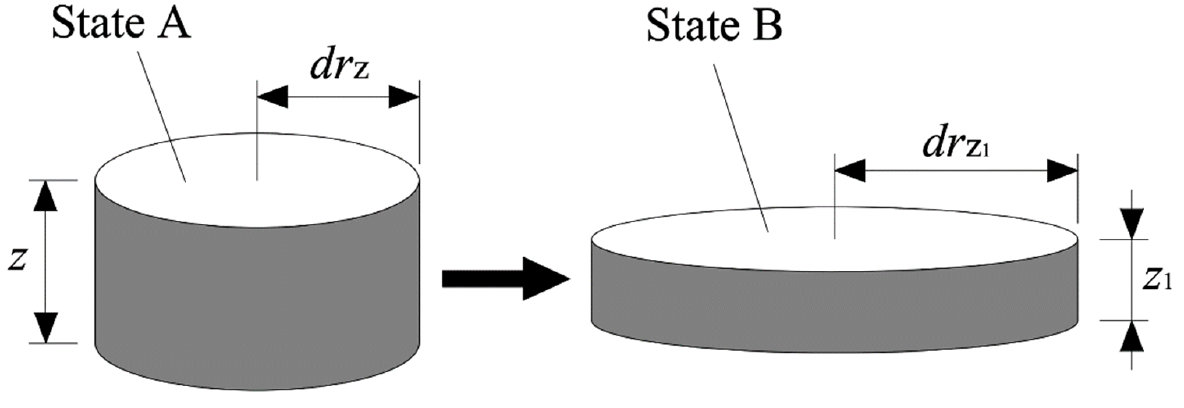
Assuming that the mixture is incompressible and the volume of the micro-unit before slump deformation (state A) is the same as that after slump deformation (state B), as shown in Figure 5.